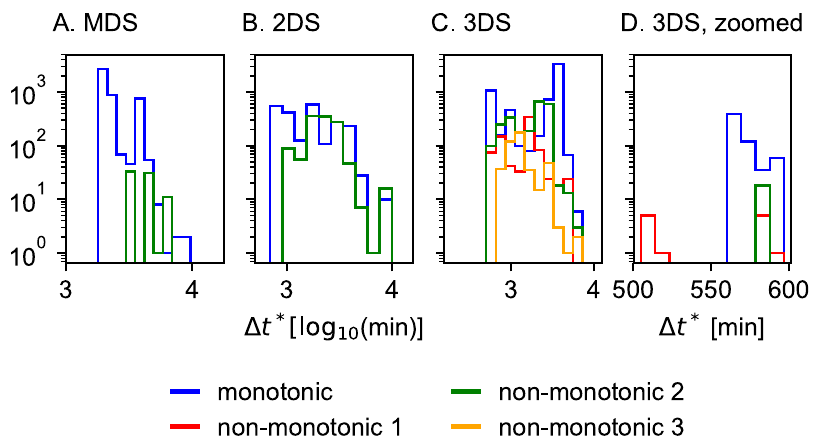
Fig 6. Distribution of induction times for the different toy models. For the MDS and 2DS no bistable non- monotonic type 1 solutions were found. For the 3DS many bistable solutions are found and the lowest inductions times are found for non-monotonic type 1 as we expected (panel D). Non-monotonic responses are not in general faster than monotonic responses (panel C): the induction time depends on the actual shape of the response curve and therefore on the parameters.